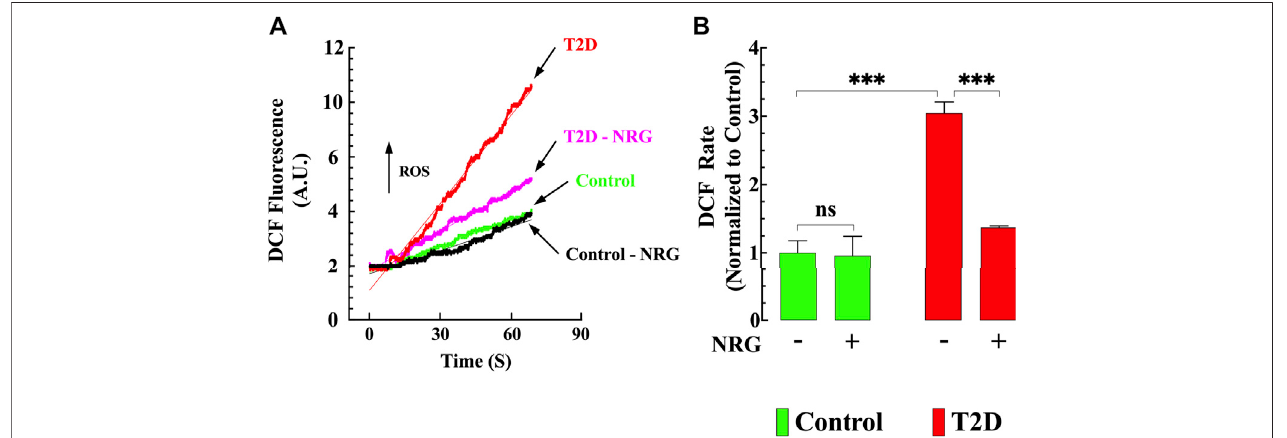
FIGURE 3 | Naringin reduced intracellular ROS generation T2D cardiomyocytes. DCF fl uorescence signal rate was signi fi cantly enhanced in T2D compared to controlcardiomyocytes. (A) Representative records ofDCF fl uorescence signal fromcontrol(black), control naringintreated (green), T2D(red), and T2Dnaringin treated (purple) cardiomyocytes. (B) Average rate of DCF fl uorescence signal from all cardiomyocytes groups. DCF fl uorescence signal measurements were obtained from n mice (cid:1) 5/ group; n cells (cid:1) 20 – 27/group. Values were normalized to control untreated cardiomyocytes and expressed as means ± S.D. Statistical analysis was performed as described before, ns p > 0.05, *** p <